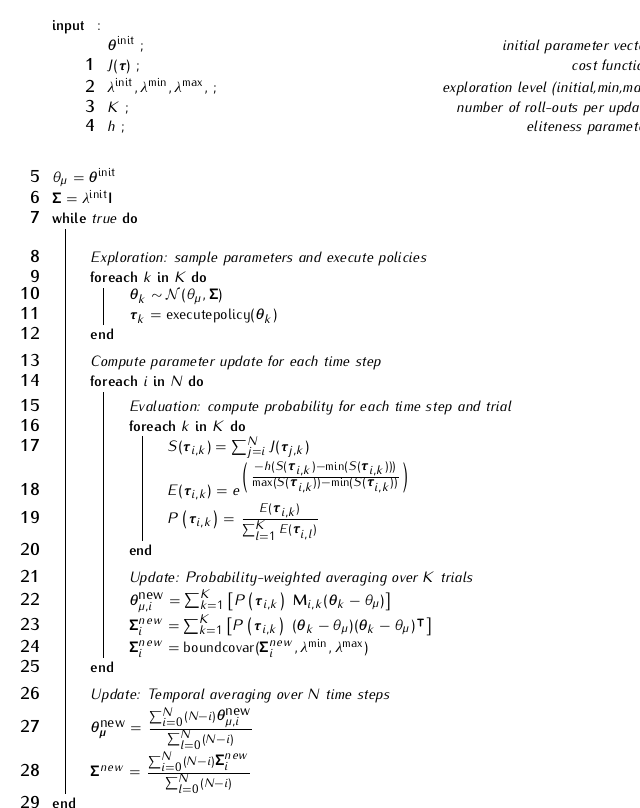
Algorithm 1: The PI 2